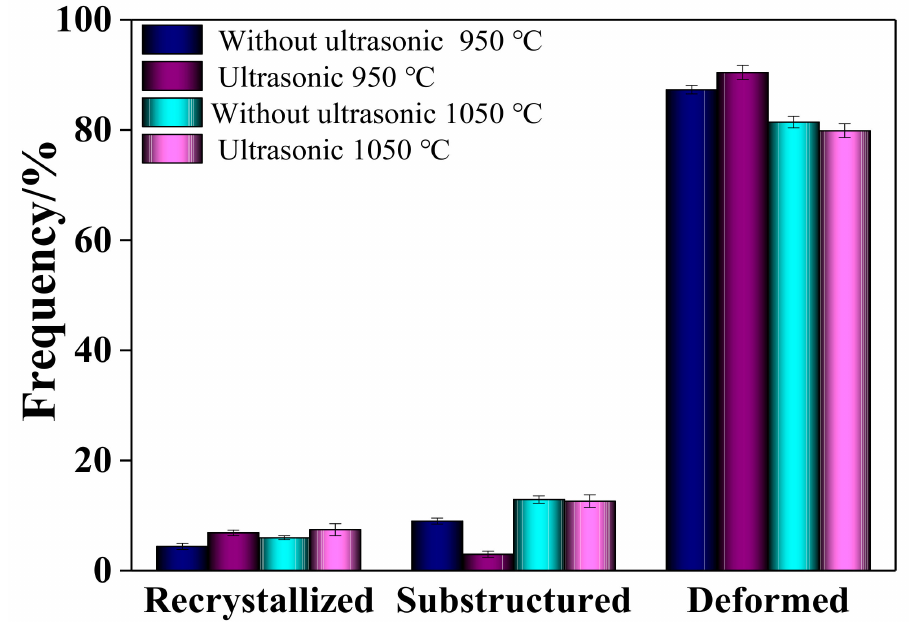
Figure 13. Evolution of deformed grains, sub-grains and DRX grains at a strain rate of 0.1 s − 1 and different deformation